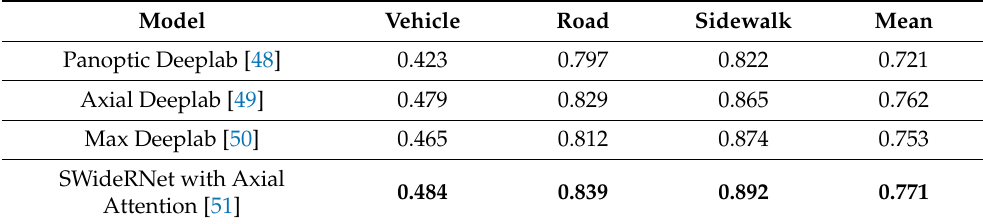
Table 1. IoU results.